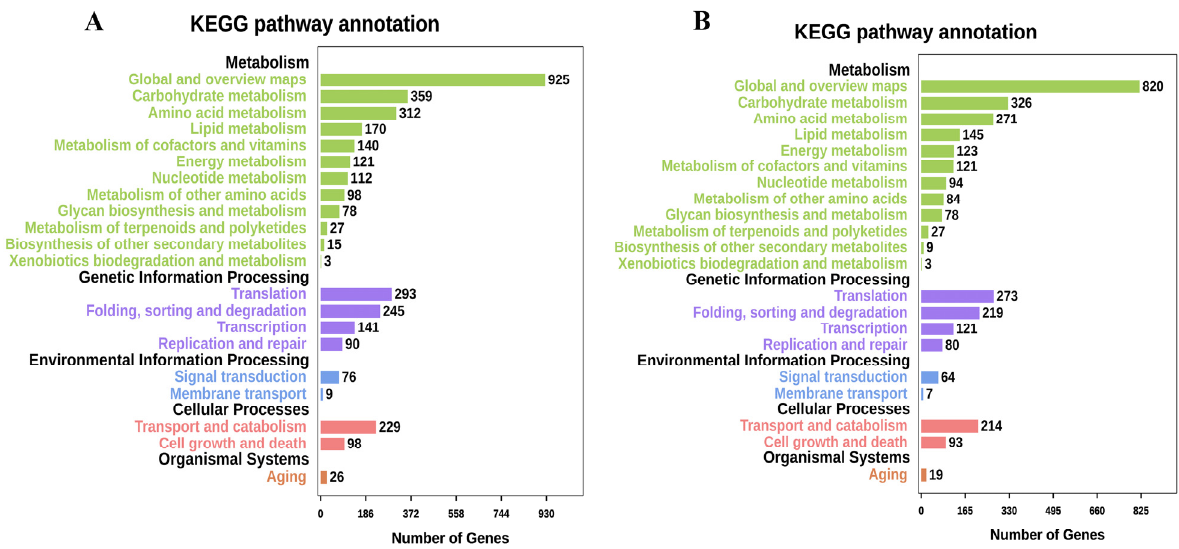
Figure 5. Kyoto Encyclopedia of Genes and Genomes (KEGG) pathway annotation of E. rostratum LWI ( A ) and B. zeicola LWII ( B ).